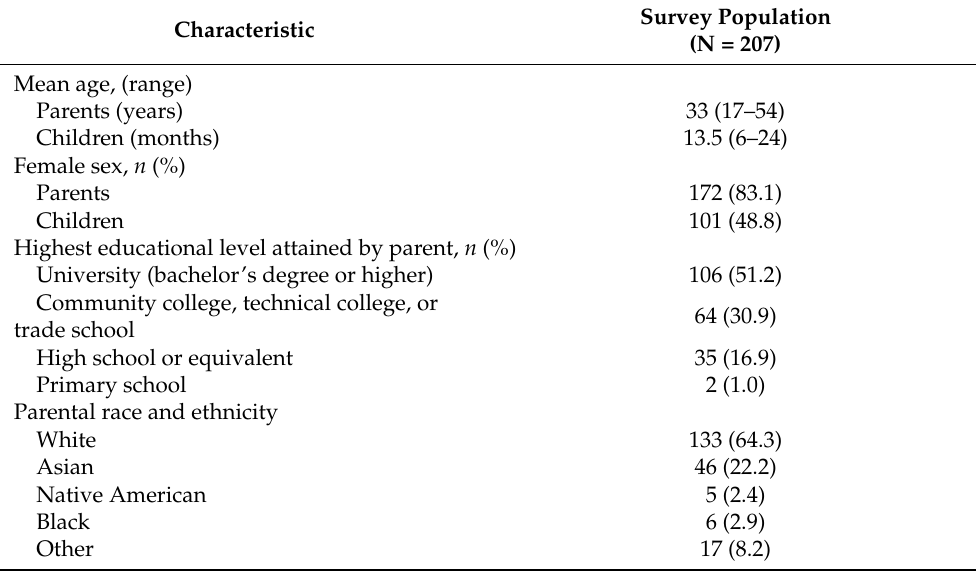
Table 1. Sociodemographic characteristics.